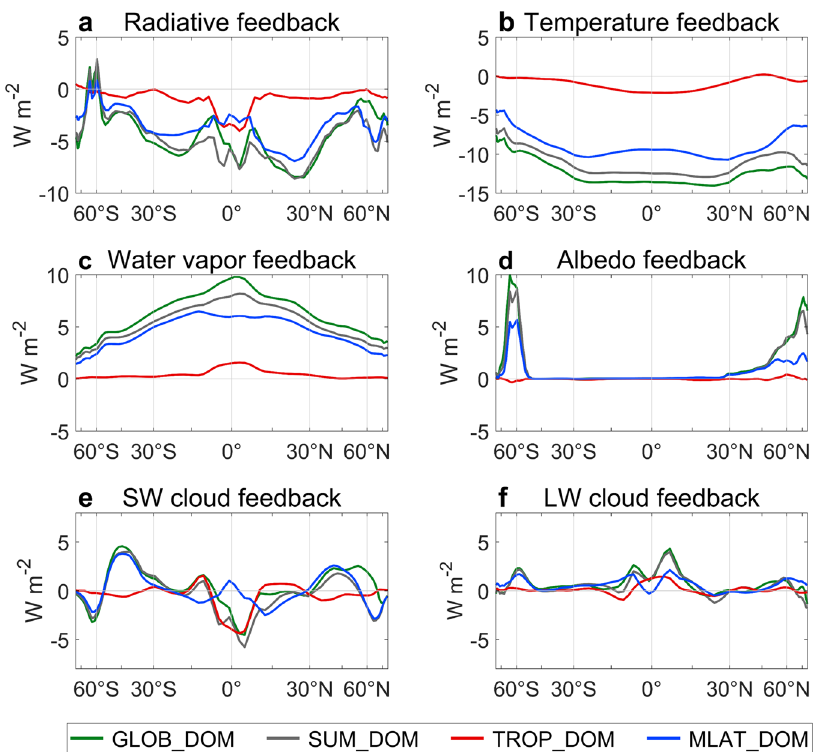
Fig. 6 Changes in radiative feedbacks in response to different CO 2 forcings. The annual- and zonal-mean pro fi le of TOA radiation responses due to a total radiative feedback Δ R Fdbk , b temperature feedback Δ R T , c water vapor feedback Δ R WV , d surface albedo feedback Δ R A , e shortwave and f longwave component of the cloud feedback Δ R C in GLOB_DOM (green), TROP_DOM (red), MLAT_DOM (blue), and the sum of all regional forcing experiments SUM_DOM